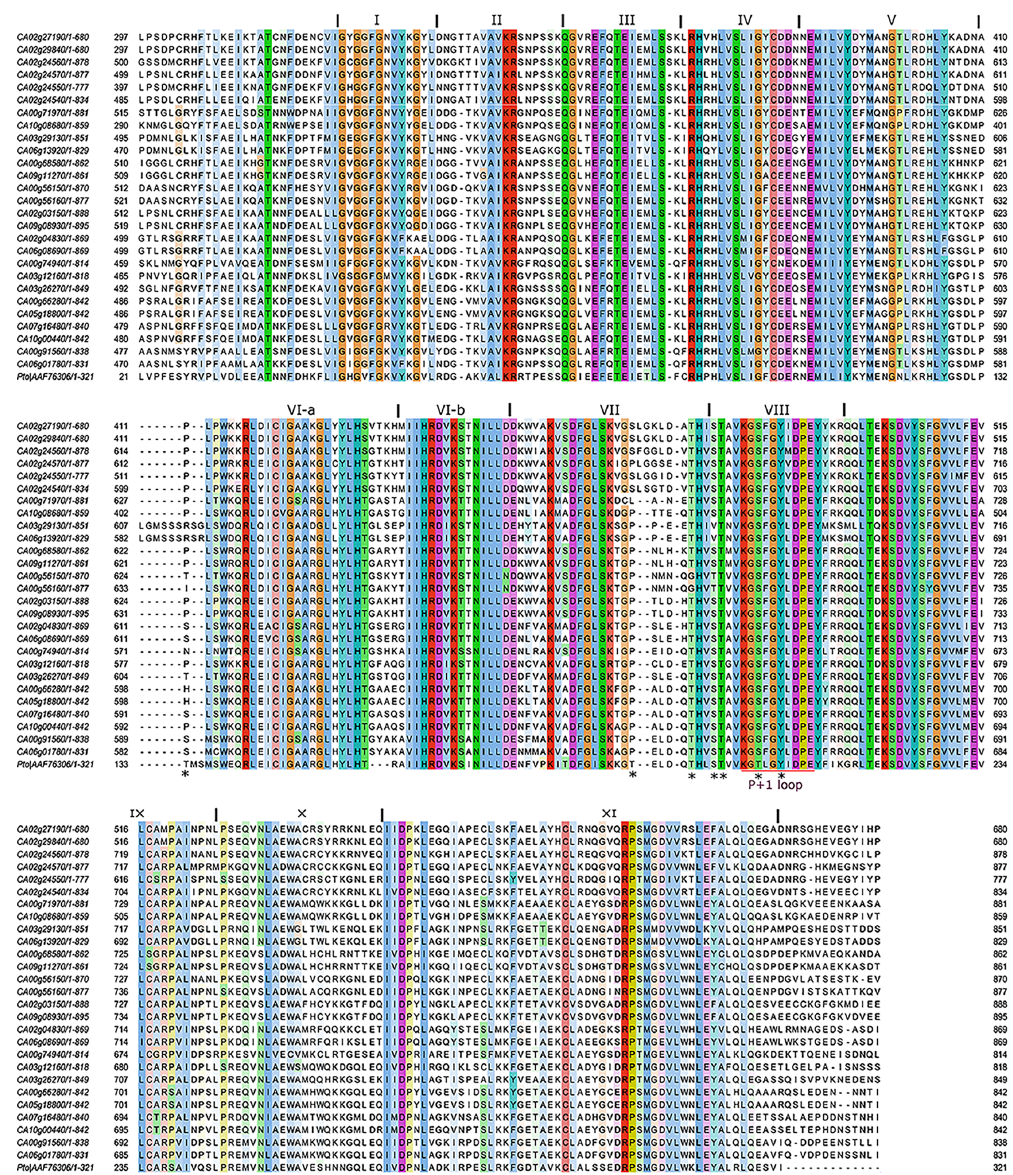
Fig 4. Multiple sequence alignments of the STK region. The STK domains were aligned using the Clustal Omega program, and the alignments were displayed in the "ClustalX" color mode available in JalView 2.8. The conserved domains I through XI are indicated in the figure. Autophophorylation sites are indicated with